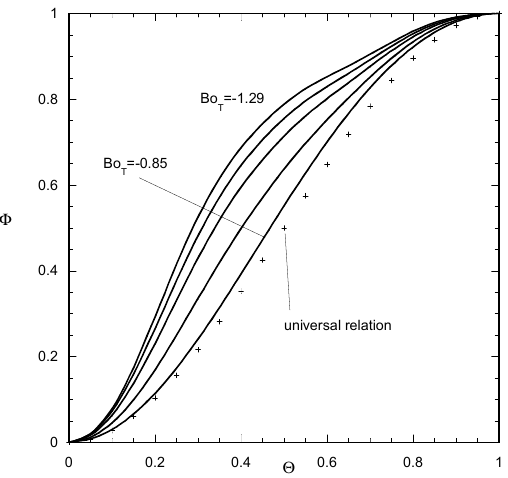
Figure 9. Normalized contact angle versus normalized azimuthal angle for the cases presented in Figure 8. The variable Bo T for the three intermediate curves is − 1, − 1.13, − 1.23, respectively (from lower to higher). The universal relation proposed in [13] is also shown.